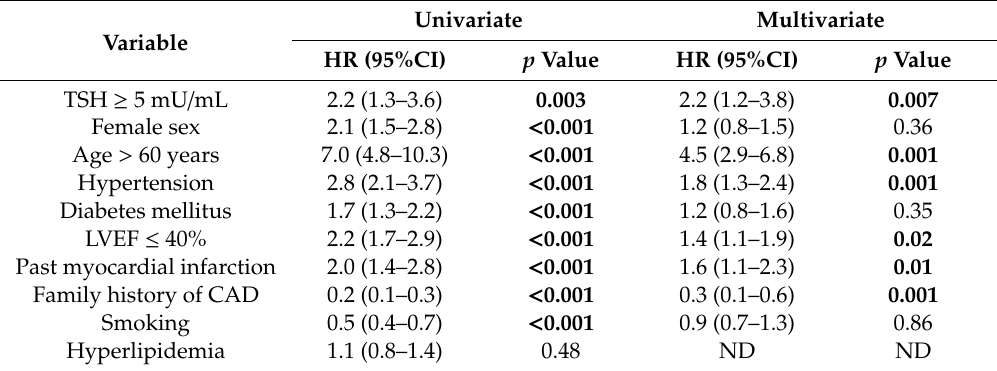
Table 4. Univariate and multivariate Cox regression model predicting long-term mortality according to the presence of subclinical